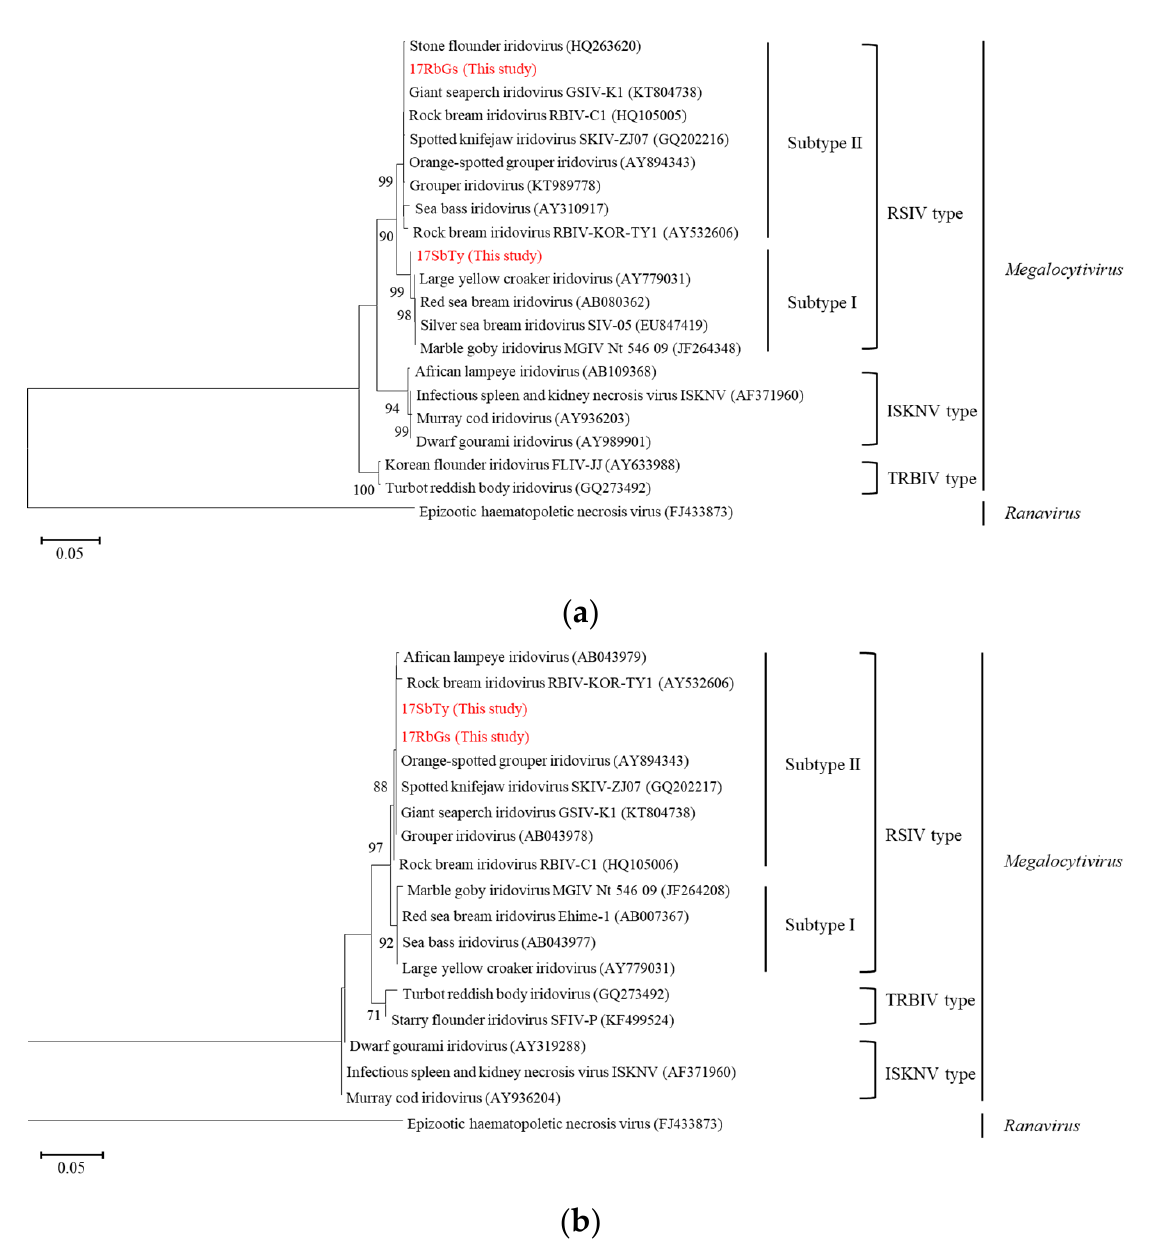
Figure 1. Phylogenetic trees based on the complete nucleotide sequences of the ( a ) major capsid protein gene (MCP; 1362 bp) and ( b ) adenosine triphosphatase gene (ATPase; 721 bp) of two red sea bream iridovirus (RSIV) isolates (17SbTy and 17RbGs) collected from cultured fish in Korea. The phylogenetic trees were constructed using the maximum-likelihood method in MEGA (ver. 11). Bootstrap values were obtained from 1000 replicates, and the scale bar represents 0.05 nucleotide substitutions per site. The two RSIV isolates (17SbTy and 17RbGs) from this study are highlighted in bold and red color.